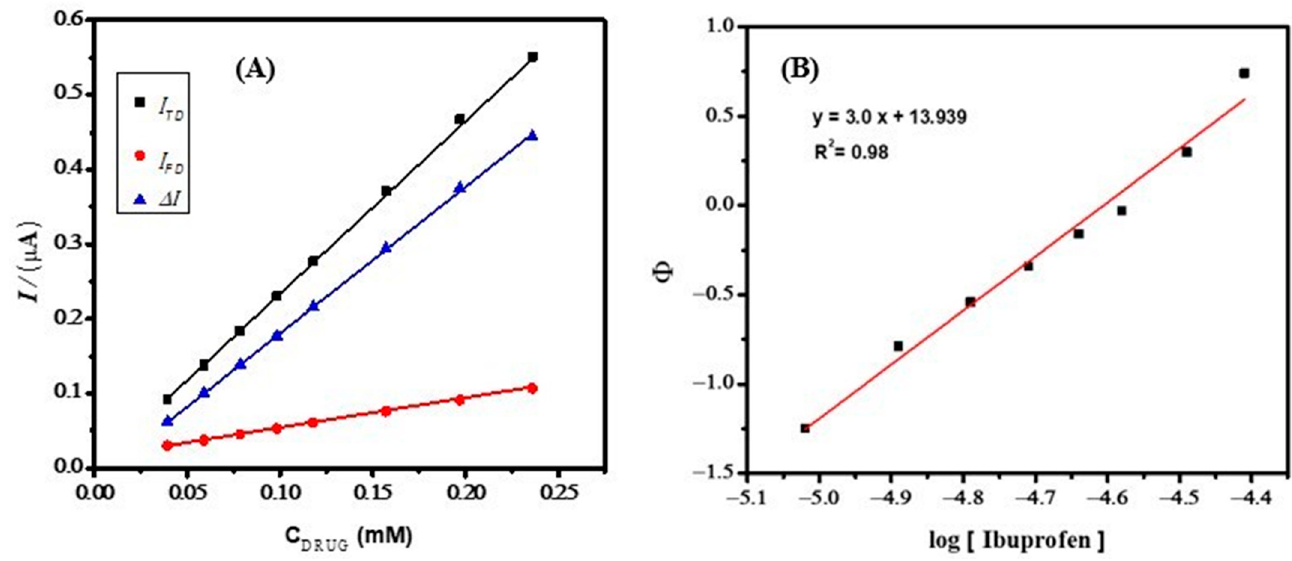
Figure 10. ( A ) Relationship of peak current vs. drug concentration for IBP and no BSA, NaOH 0.9 M, and 5 µ M BSA + NaOH 0.9 M, and punctual difference between the values of I TD and I FD ( ∆ I = I TD − I FD ) ( B ) relationship between Φ and log [FD] in the case of IBP with BSA, an example of a formation with a single type of complex.